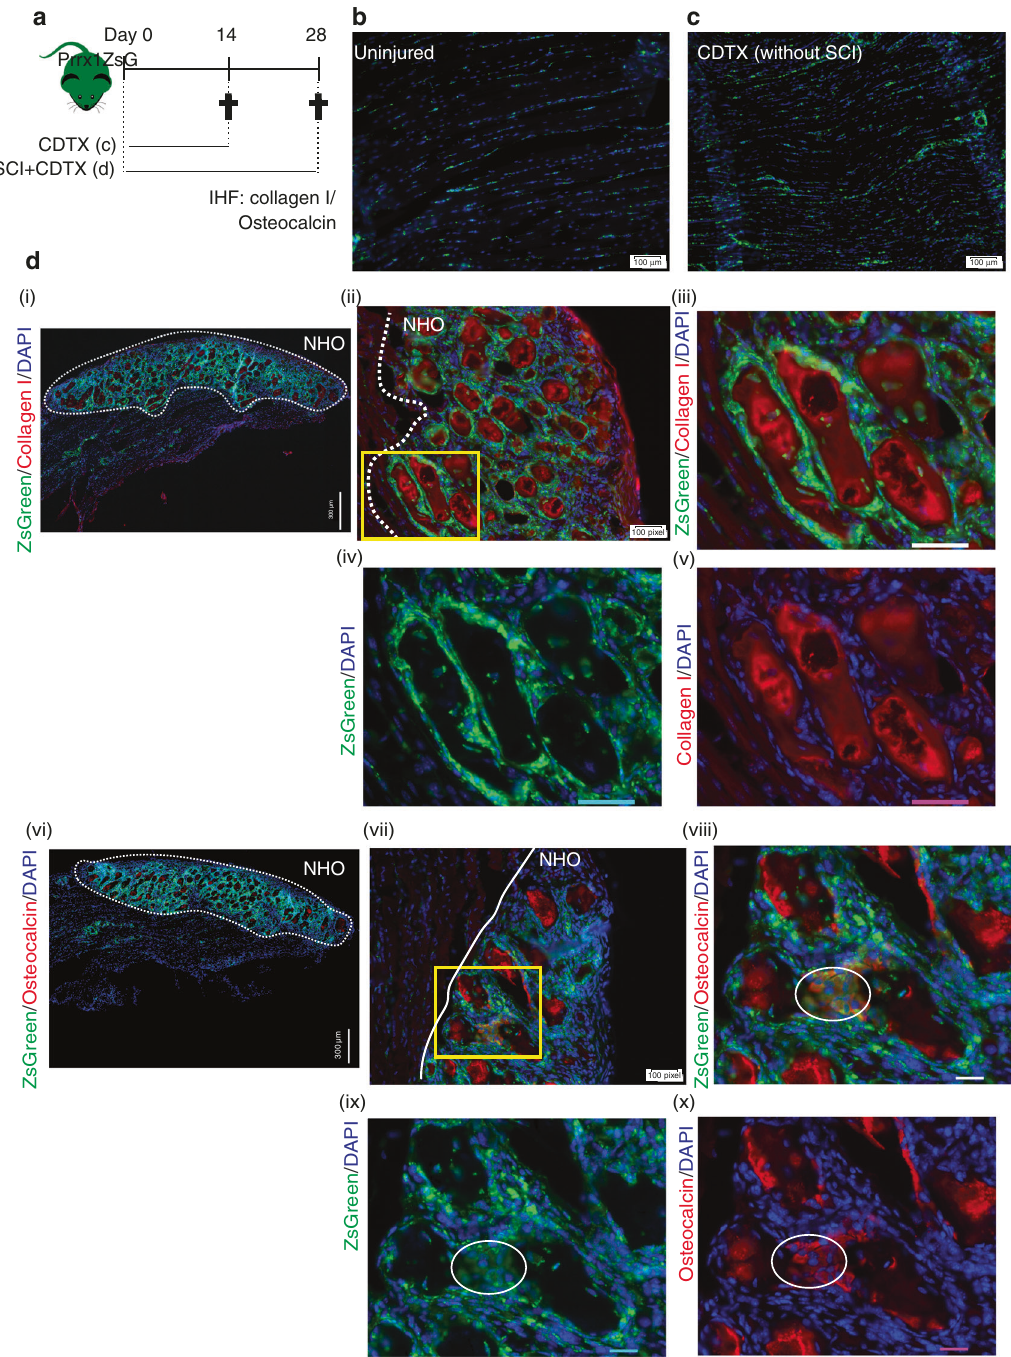
Fig. 3 NHOs are derived from Prrx1 expressing FAPs. a Prrx 1 ZsG mice received an intramuscular injection of CDTX with or without SCI, and muscle samples were harvested at the indicated time points and processed for IHF. Representative images illustrating the distribution of ZsGreen + FAP- derived cells in ( b ) uninjured muscle and c regenerated injured muscle 14 days post-CDTX injection in the Prrx1 ZsG mice without SCI ( n = 3 mice/ group). d Representative images from the Prrx1 ZsG mice with SCI and CDTX-mediated muscle injury 28 days post-surgery: IHF illustrating the colocalization of ZsGreen + FAP-derived cells with ( i – v ) collagen I + matrix (red) or ( vi-x ) osteocalcin + osteoblasts (red). ( iii-v ) are enlarged images of the yellow box in ( ii ), whereas ( viii-x ) are enlarged images of the yellow box in ( vii ). The white dashed line indicates the boundary between regenerating muscle and the fi brotic area containing NHOs. Nuclei stained in DAPI (blue). White circles indicate osteocalcin + osteoblasts that also express ZsGreen. Scale bars: ( b , c ) 100 μ m; ( d ) (i) 300 μ m ( ii, vii ) 100 μ m ( iii-v, viii-x ) 50 μ NHOs following SCI may come from the circulation, these would CDTX muscle injury of the recipients. Muscles were analyzed by be extremely rare compared to the abundance of Prrx1 - histo fl uorescence 21 days later, and none of the CDTX-injured expressing ZsGreen + FAPs already present in the muscle prior muscles contained any ZsGreen-positive cells (result not shown). Therefore, while we cannot completely exclude the possibility to injury. Therefore, NHOs are most likely derived from muscle- that some of the Prrx1 -expressing ZsGreen + cells associated with resident FAPs.